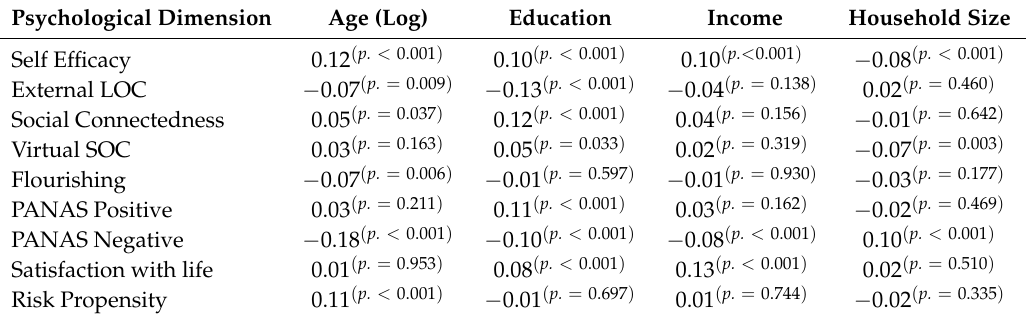
Table 2. Pearson r. correlations between psychological variables of the sample and socio- demographic